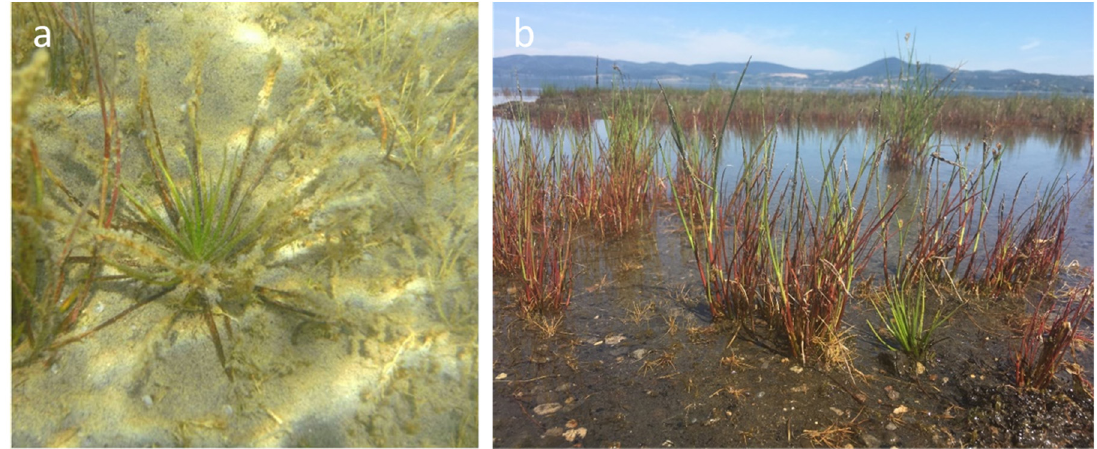
Figure 1. Isoëtes sabatina in Lake Bracciano ( a ) growing completely submerged on a sandy substrate at a depth of 1.5 m (summer 2013) and ( b ) completely emerged in the summer of